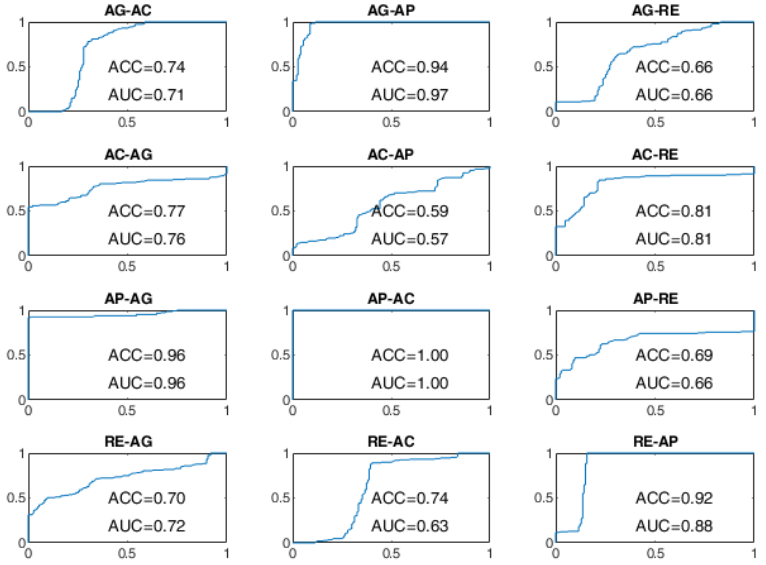
Figure 10 . ROC curves of the BLSTM-AE approach on the DS1 dataset for WD = 15 s.